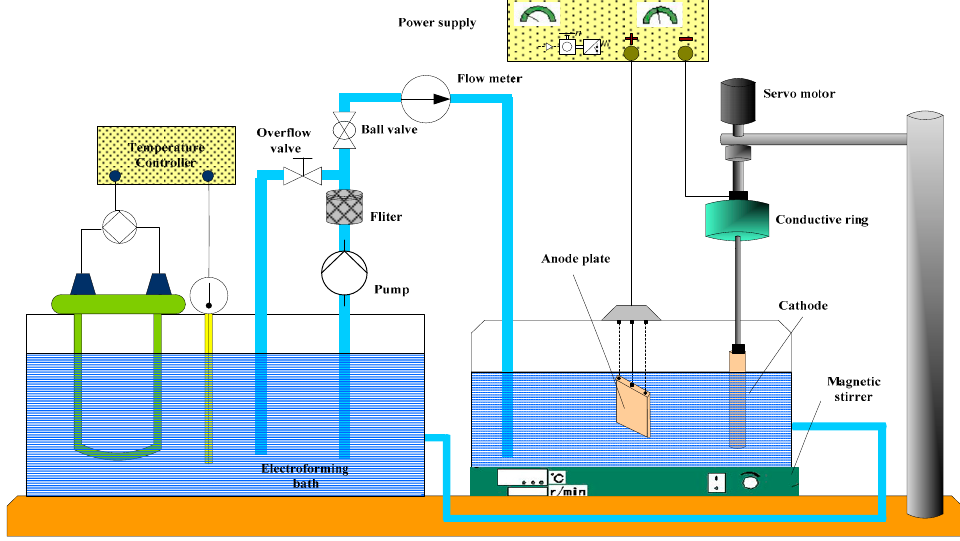
Figure 1. Schematic diagram of electroforming system.